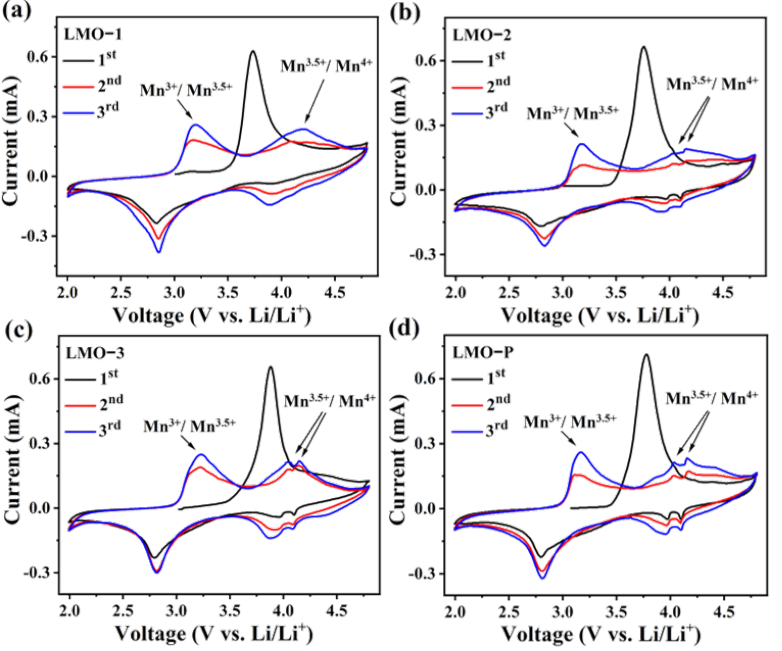
Figure 4. Cyclic voltammograms (CVs) of the various samples in the potential range of 2.0–4.8 V ( a – d